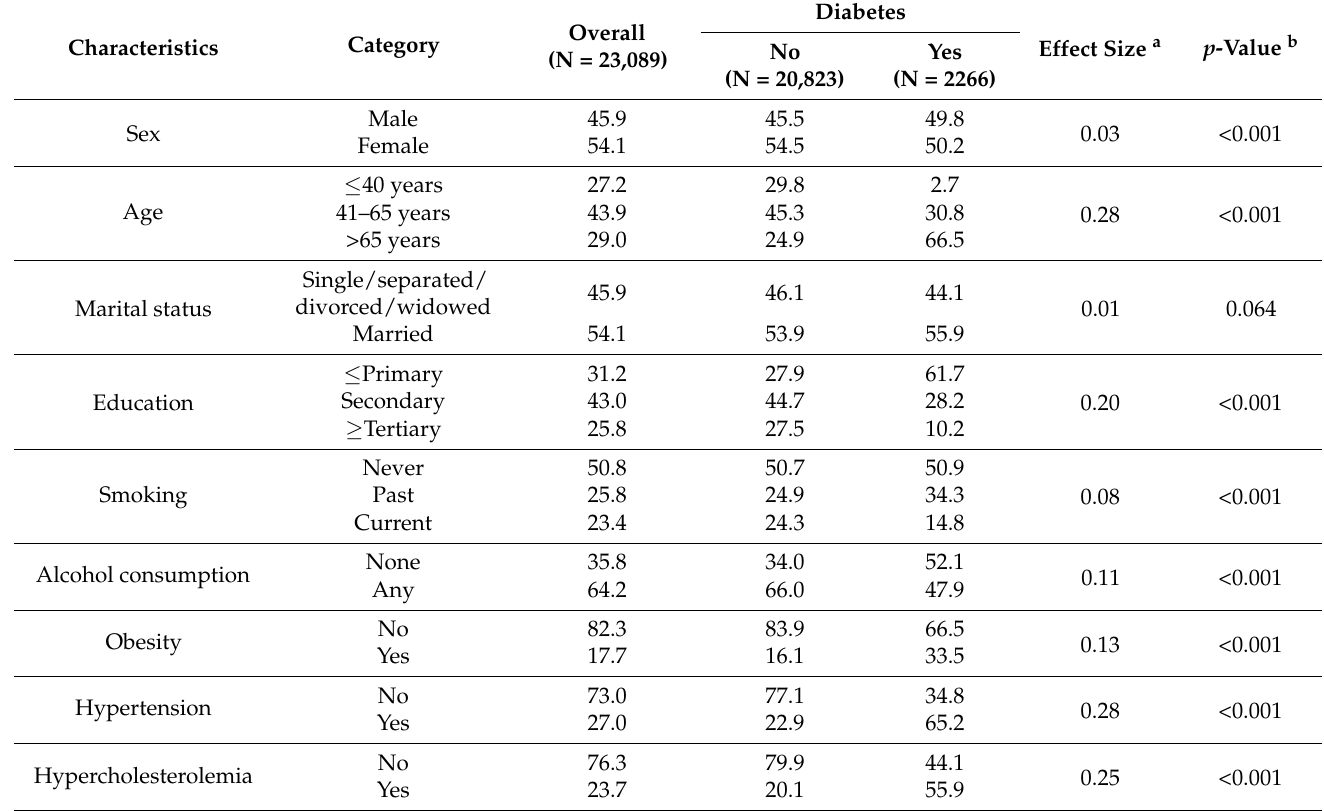
Table 1. Sample characteristics (overall and by diabetes